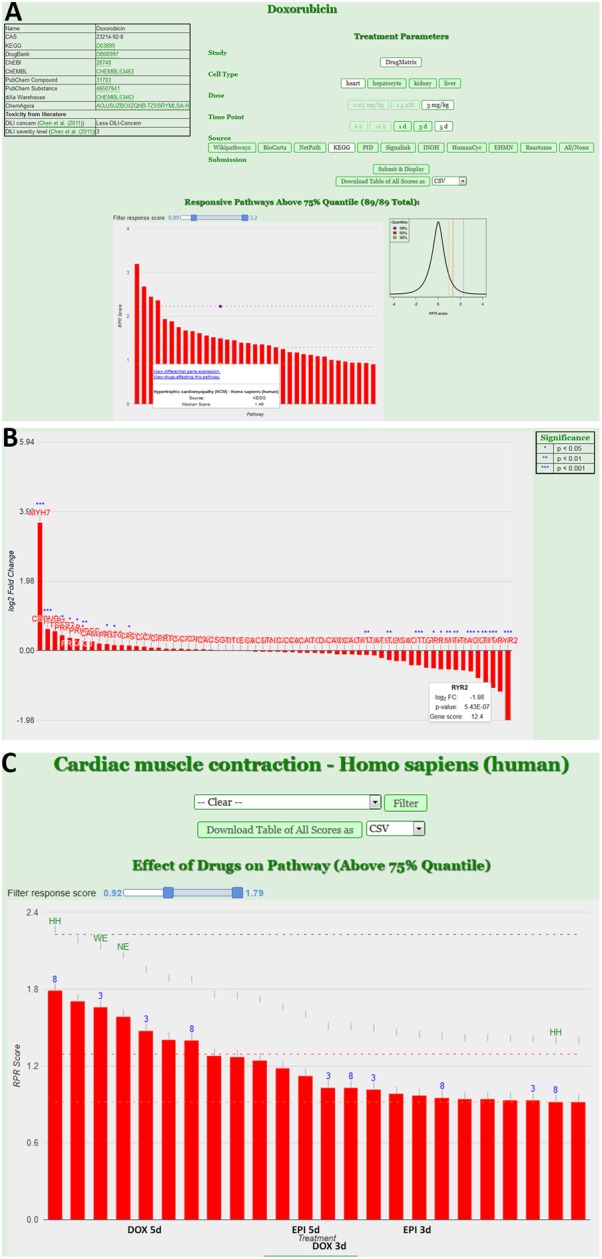
Pathway analysis using the ToxDB. (A) Drug view contains links to chemical information (top left), specification of the experimental data (top right) and the display of the response pathways for that experiment in form of an interactive bar plot. Bars indicate the strength of the response, with mouse over the user can display further information of the pathway. The background distribution of the response scores is displayed as density plot next to the plot. (B) Gene view. Once a pathway is selected, user can inspect the experimental results of the genes. In this case the log2 fold-changes of the genes associated with the pathway “Hypertrophic cardiomyopathy (HCM)” from the KEGG database are shown. Stars indicate differentially expressed genes (DEGs). (C) Pathway view. Users can infer specific pathways (here “Cardiac muscle contraction”). The interactive bar plots represents the response of that pathway in different experiments (e.g., DOX and EPI at 3 and 5 days experiments).